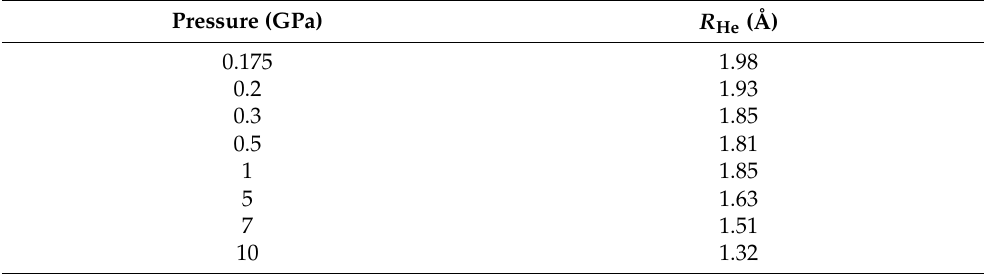
Table 3. Radii of helium droplets at 843 K as a function of the